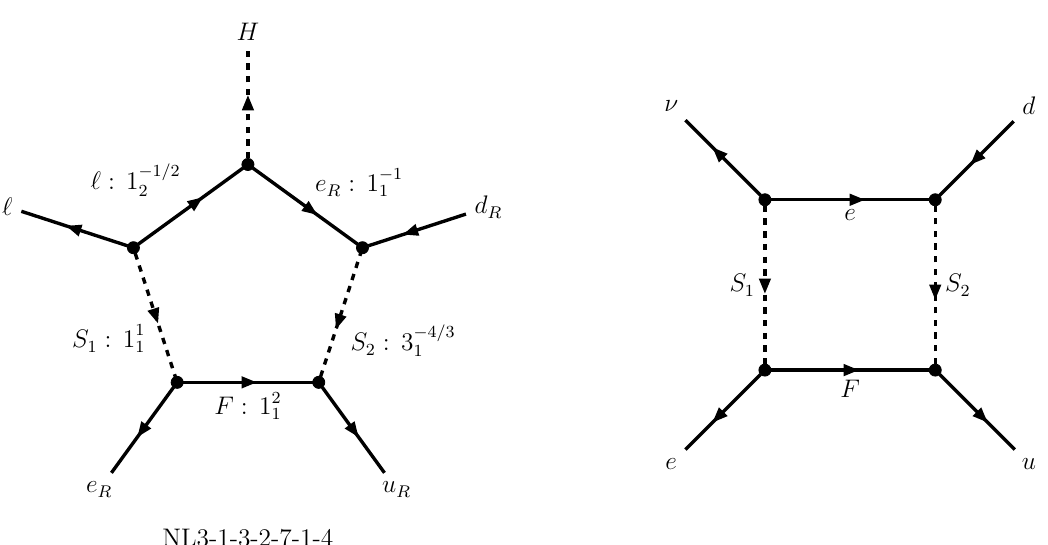
Figure 14 . The example model NL3-1-3-2-7-1-4 of one-loop 0 νββ decay. After electroweak symmetry breaking, the corresponding Feynman diagram is shown in the right panel. For this model, the neutrino mass is generated at three-loop level, as shown in figure 15 and figure